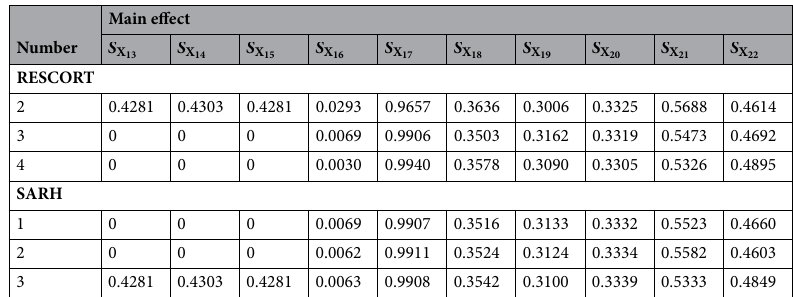
Table 8. Main effect value of indicators X 13 ∼ X 22 .